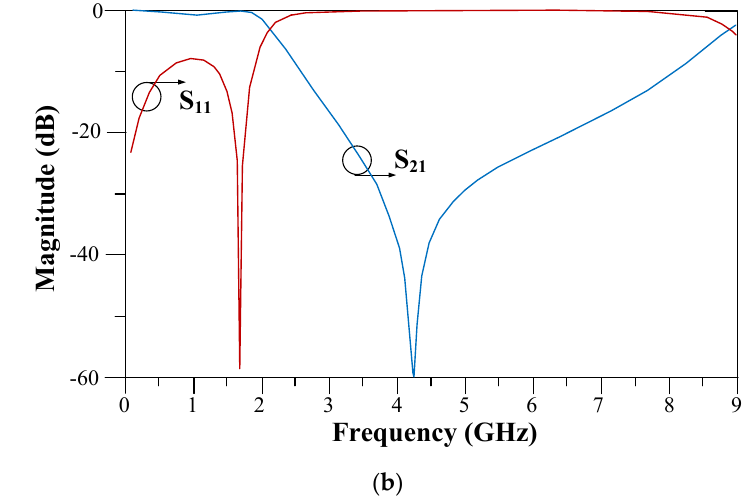
Figure 10. Improved initial vertical resonator: ( a ) layout and ( b ) frequency response. All dimensions are in the millimeter unit.